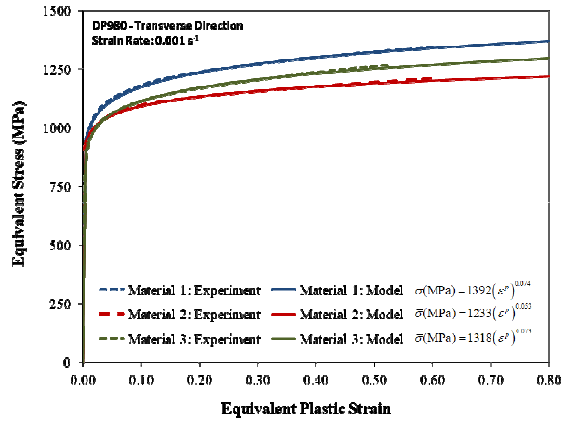
Fig. 13. Experimental strain sensitivity of each material studied. Fig. 14 serves to compare the measured strain rate sensitivity of Material 2 with the predictions from the JC model. The predictions for the other materials were of similar quality.